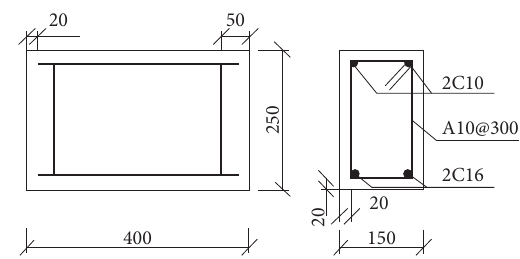
Figure 1: Size and reinforcement diagram of concrete specimen (unit: